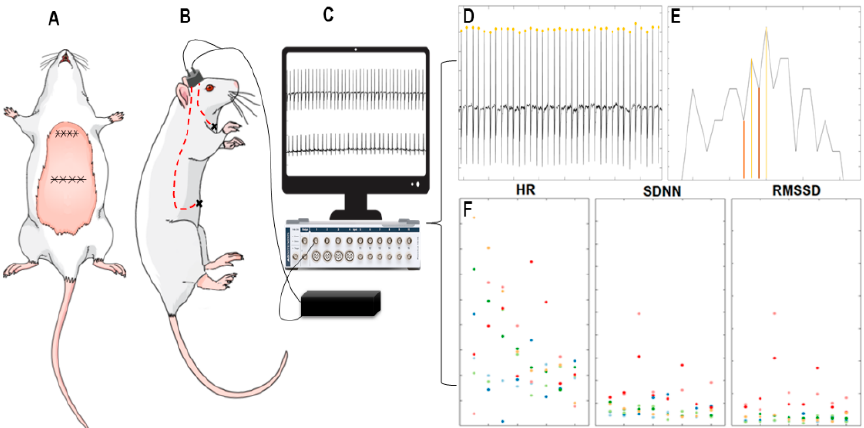
Figure 2. Schematic figure of the cardiac lead implantation and signal analysis. ( A ) Suture indicating the location of the xiphoid process and sternocleidomastoid musculature. ( B ) The acrylic structure in the rat skullcap with the cardiac electrode output connected to the electrocardiogram (ECG) register acquisition equipment. The red lines indicate the cardiac electrode wires placed subcutaneously. ( C ) Cardiac lead output connected to the biological signal amplifier with output for PowerLab v8 data digitizer and representative electrocardiographic record. ( D ) Identification of the amplitude of each R point of the analyzed stretch represented by the yellow dot. ( E ) Tachograph of R-R points. Vertical lines identify the R peaks. The distance between the lines on the x-axis represents the distance R-R. The height, on the y-axis, represents the maximum amplitude of the R peak. ( F ) Average heart rate, standard deviation of all normal-to-normal intervals (SDNN), and square root of the mean of the squared differences between adjacent normal RR intervals (RMSSD) dispersion of each stretch analyzed by group of animals. Picture created on the Mind the Graph platform (mindthegraph.com)